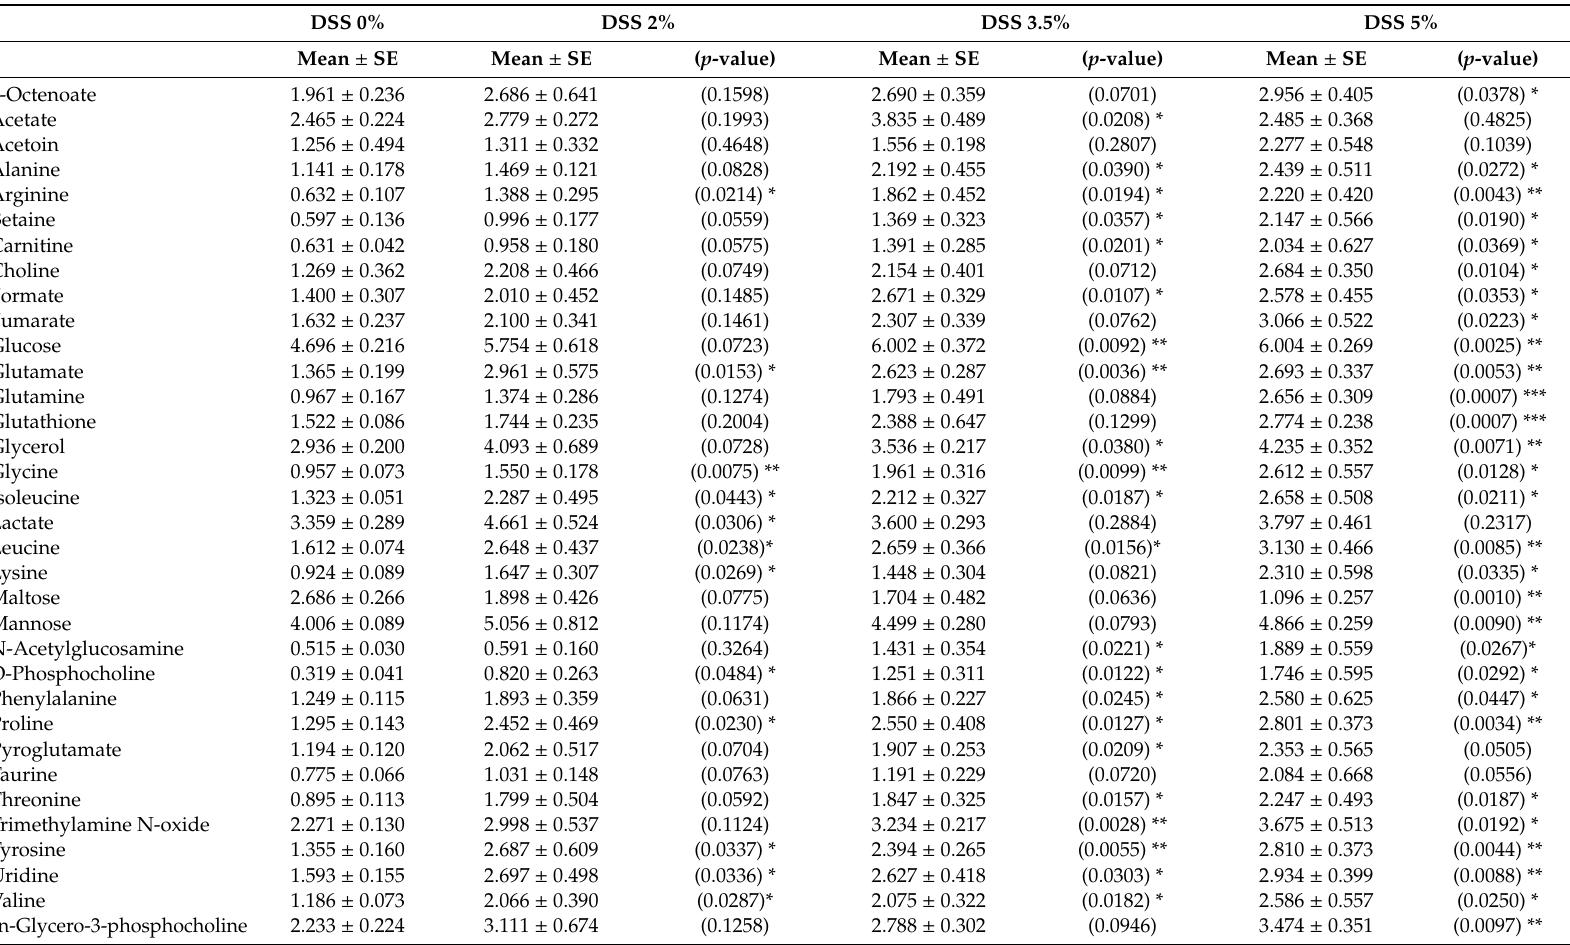
Table 2. The relative concentrations of metabolites acquired by 1 H-NMR spectroscopy from DSS 0%, DSS 2%, DSS 3.5%, and DSS 5%